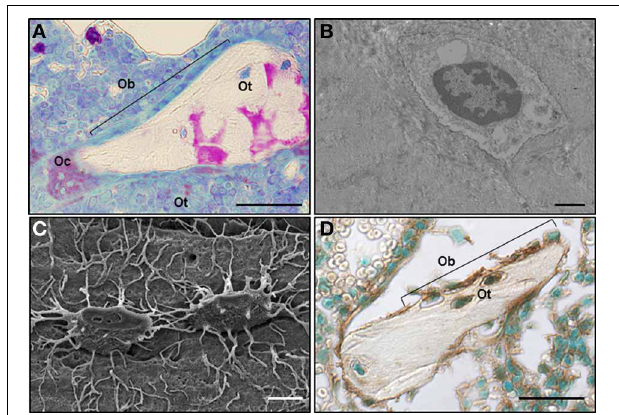
FIGURE 1 | Cell-to-cell interactions among osteoclasts, osteoblasts, and osteocytes in close proximity maintain bone homeostasis. (A) An osteoclast (Oc), a team of osteoblasts (Ob) and bone-embedded osteocytes (Ot) are shown in a rat bone section, in which osteoclasts were stained for the osteoclast-specific enzyme tartrate resistant acid phosphatase (TRAPase) (red) and counterstained using Toluidine blue. Scale bar indicates 50 μ m. Picture contributed by Keith W. Condon (Indiana University School of Medicine). (B) Transmission electron microscope image of an osteocyte embedded in the bone matrix. Image was obtained at the Electron Microscopy Center of the Department of Anatomy and Cell Biology (Indiana University School of Medicine). Scale bar indicates 5 μ m (C) Scanning electron microscope image of an acid-etched bone showing two osteocytes highly communicated through their cytoplasmic projections (Bellido et al., 2014). Scale bar indicates 1 μ m. (D) Cx43 immunostaining of a section of cancellous bone showing osteoblasts (Ob) on the bone surface and osteocytes (Ot) embedded in the bone matrix stained for Cx43 (brown) and counterstained with Methyl green (Plotkin et al., 2008). Scale bar indicates 50 μ